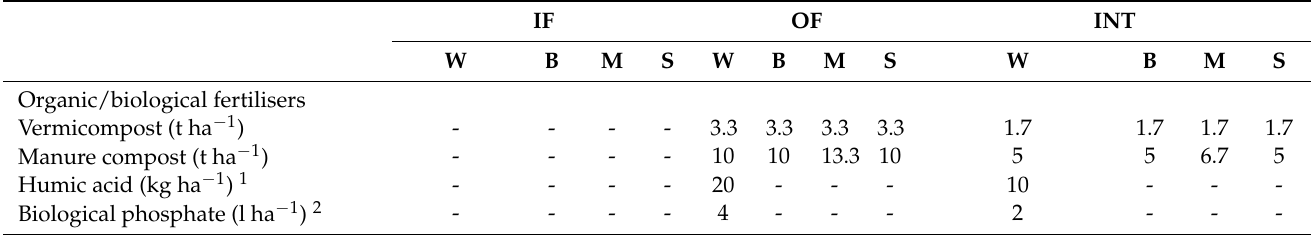
Table 1. Complete information on applied organic/biological (air-dried vermicompost and compost, humic acid, and biological phosphate) and inorganic fertilisers (N-P-K), crop residues, herbicides, and fungicides in the three farm management practices consisting of intensive (IF), integrated (INT), and organic (OF) practices. The four crops consisted of wheat (W), mung bean (B), maize (M), and sesame (S). The experiment lasted from 2018 to 2020 at the experimental plots in Ahvaz, Khuzestan province,